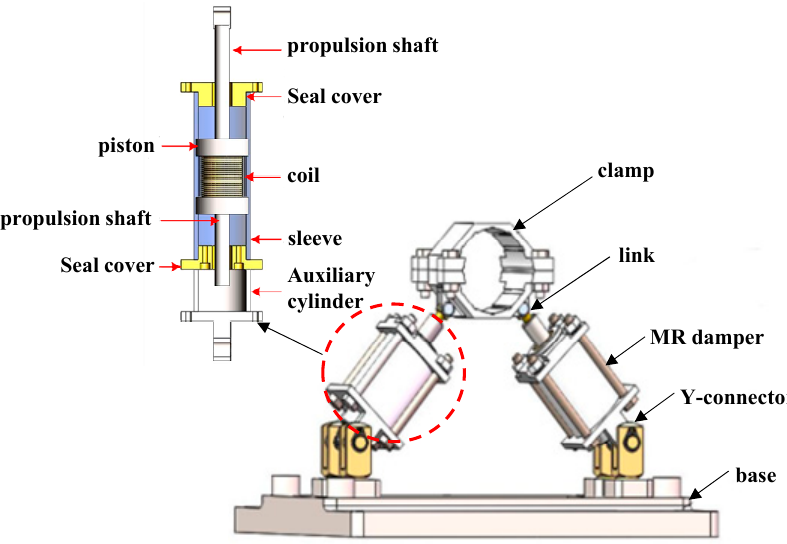
Figure 2. Structure and schematic of magnetorheological damping clamp.